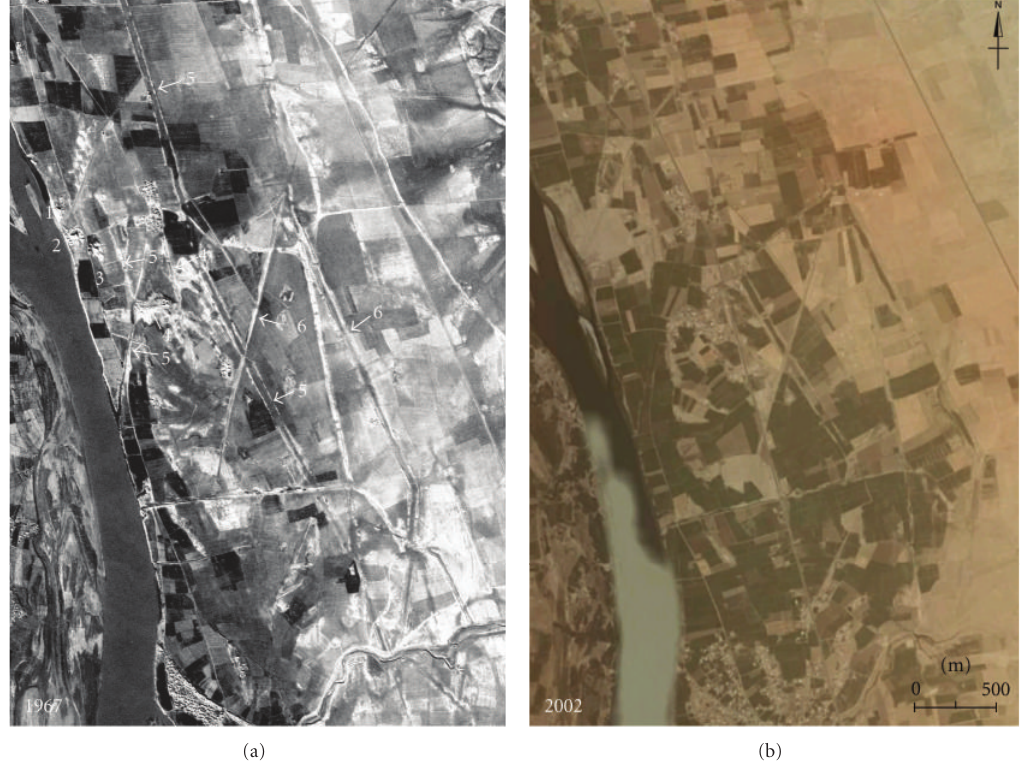
Figure 4: (a) Corona KH-4B image of 1967 and (b) pan-sharpened (bands 3-2-1) QuickBird-2 image of 2002 showing the area of Kar- Tukulti-Ninurta. In the old space photo, the remains of the ancient capital city are well visible: (1) north Palace; (2) Ashur Temple and Ziggurat; (3) south Palace; (4) city walls; (5) Assyrian canals; (6) Islamic